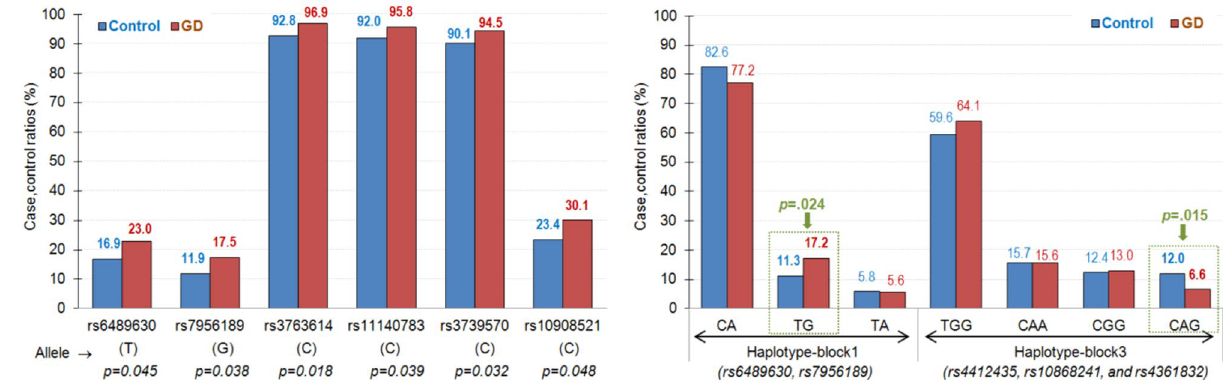
Figure 1. Single markers (first panel) and haplotype blocks (second panel) associated to the presence of GD. Adjusted p-values for correcting increase in Type-I error due to multiple null-hypothesis tests.